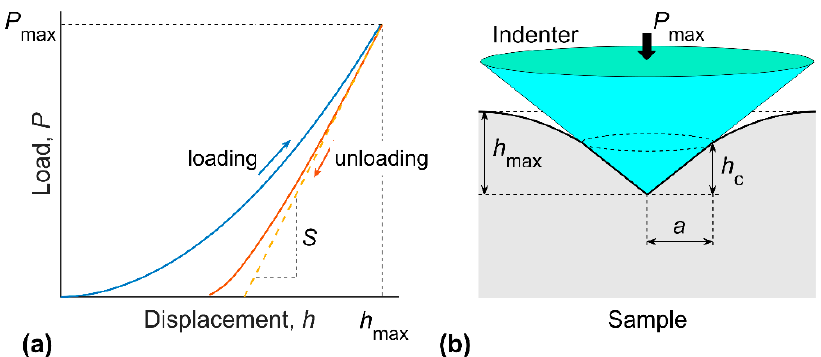
Figure 1. ( a ) Load versus displacement curve and ( b ) deformation of a sample upon indentation by a conical indenter.